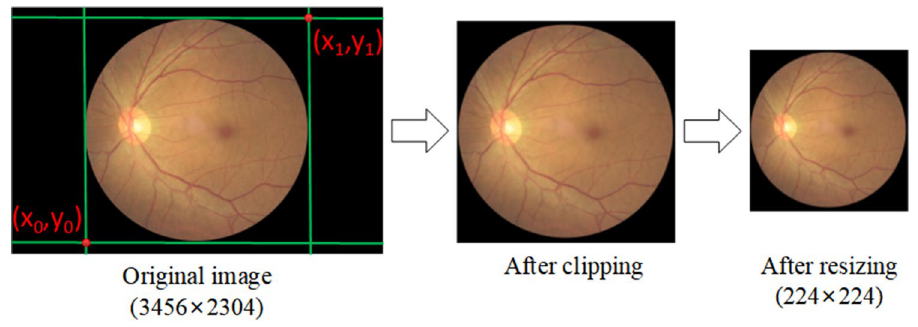
Figure 6. Processing of original training